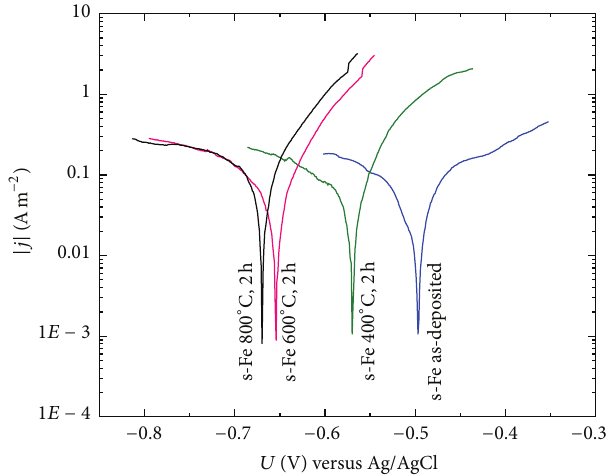
Figure 9: Exemplary Tafel-curves of s-Fe annealed at different tem- peratures for two hours. With increasing annealing temperatures a shift of 𝑈 𝑐 to more negative values and slight increase of 𝑗 𝑐 is